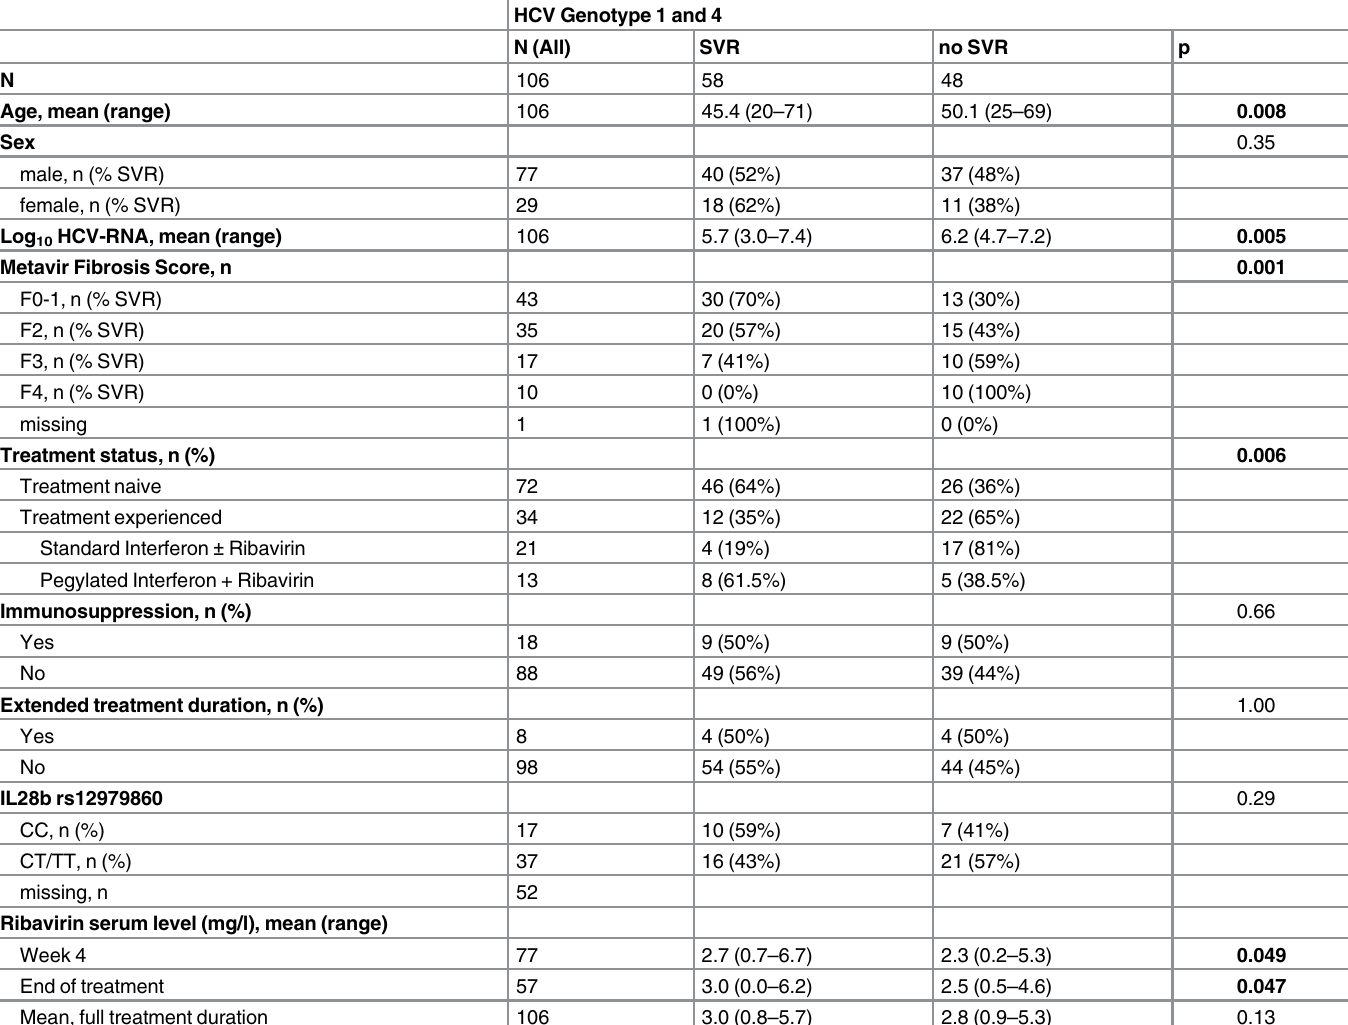
Table 2. Patient characteristics and SVR rates for HCV Genotypes 1 and